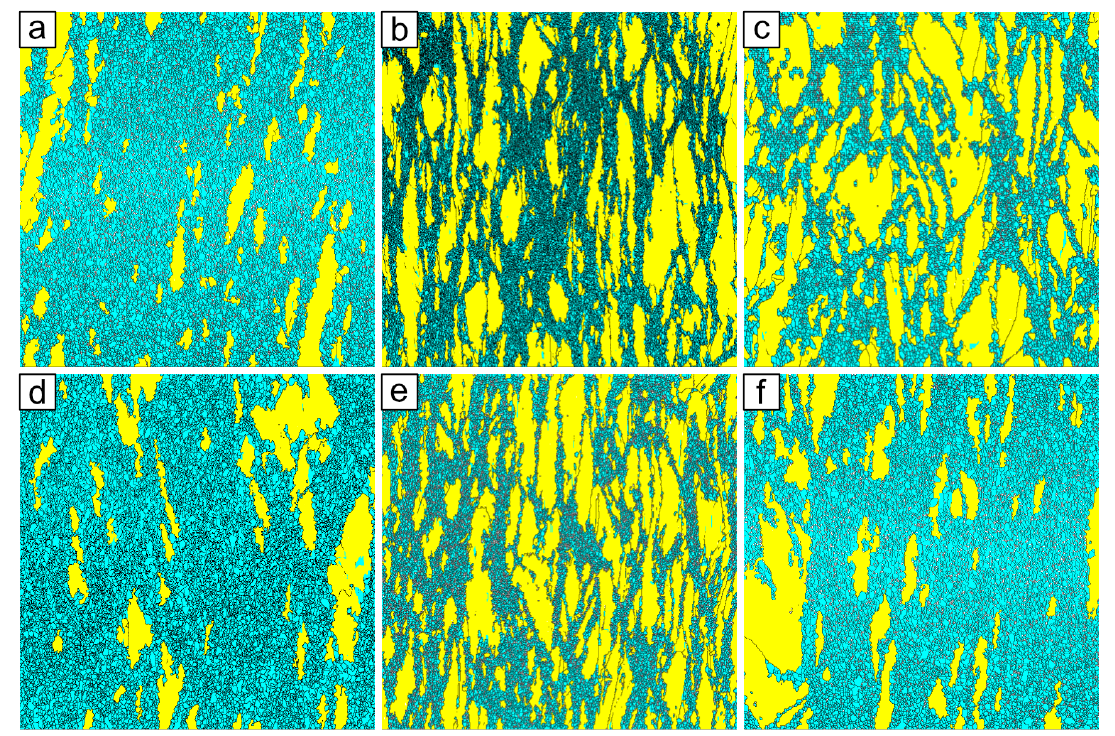
Figure 9. Maps showing the recrystallized (blue) and deformed (yellow) grains separated by a grain size specific to each sample. Black lines show HAGB > 10 ◦ . ( a – c ) are maps of Q samples deformed at 1060 ◦ C and ( a ) 0.05 s − 1 (cut-off grain size d c = 12 µ m), ( b ) 0.5 s − 1 ( d c = 7 µ m) and ( c ) 5 s − 1 ( d c = 10 µ m). ( d – f ) show Q samples deformed at 1080 ◦ C and ( a ) 0.05 s − 1 ( d c = 15 µ m), ( b ) 0.5 s − 1 ( d c = 7 µ m) and ( c ) 5 s − 1 ( d c = 12 µ